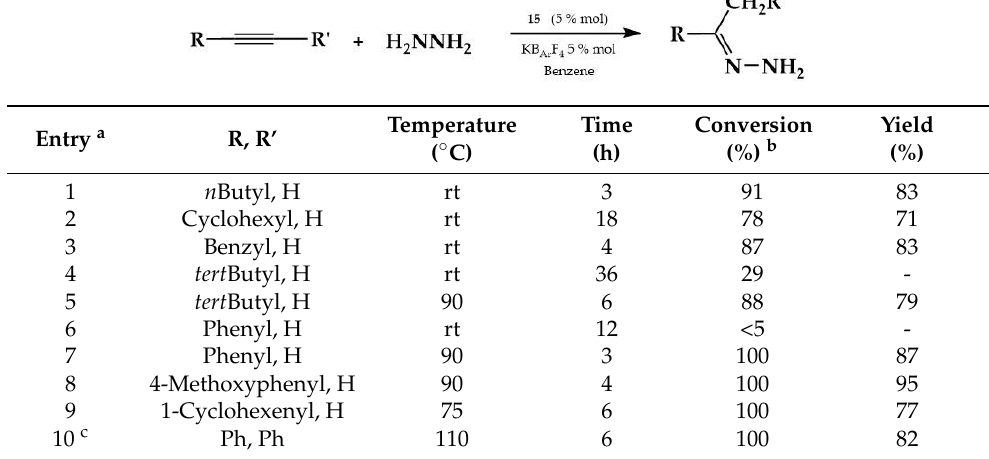
Table 3. Catalytic hydroamination of alkynes with hydrazine.